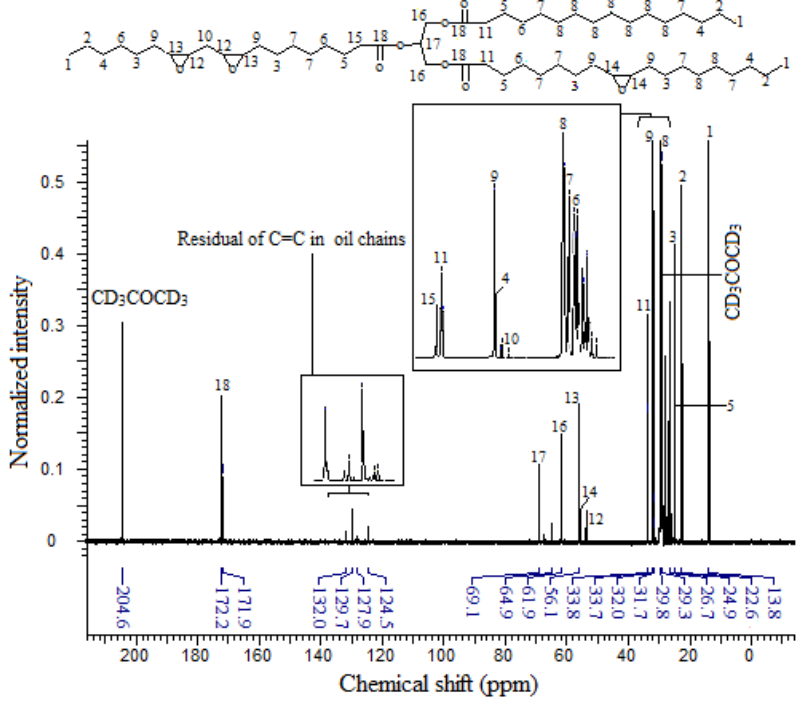
Figure 6. 13 C-NMR Spectrum of